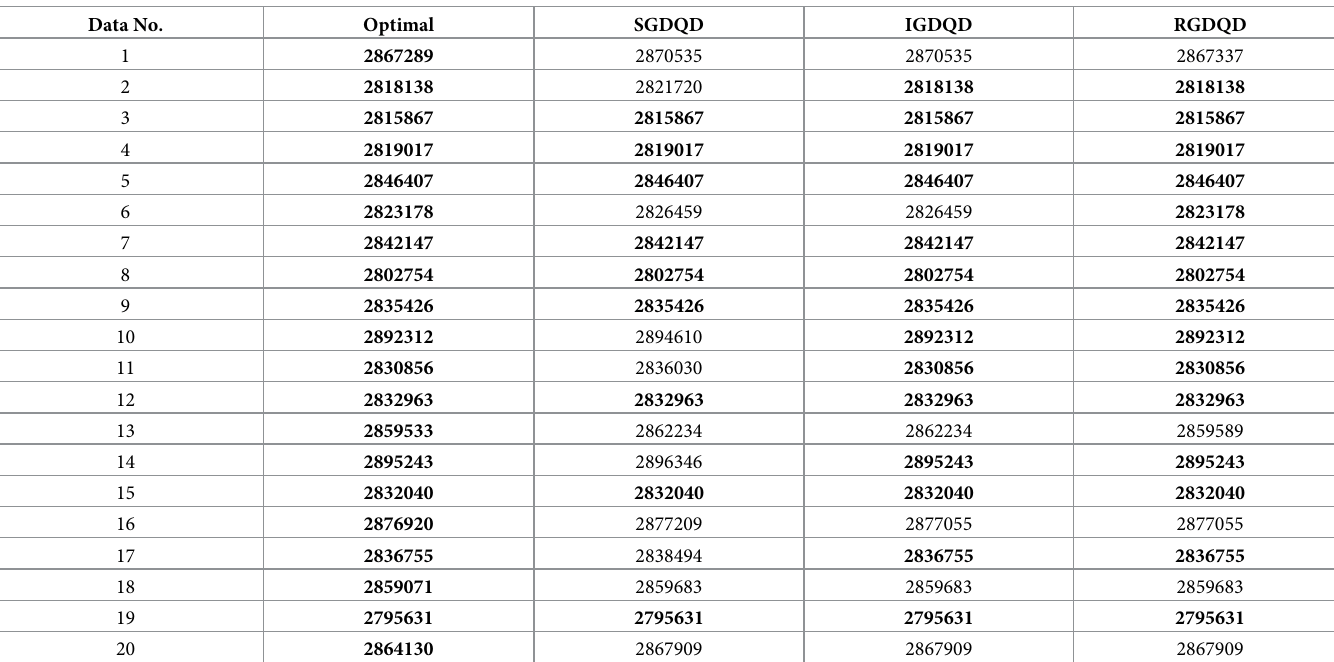
Table 11. Solutions for Q = 300000. Data